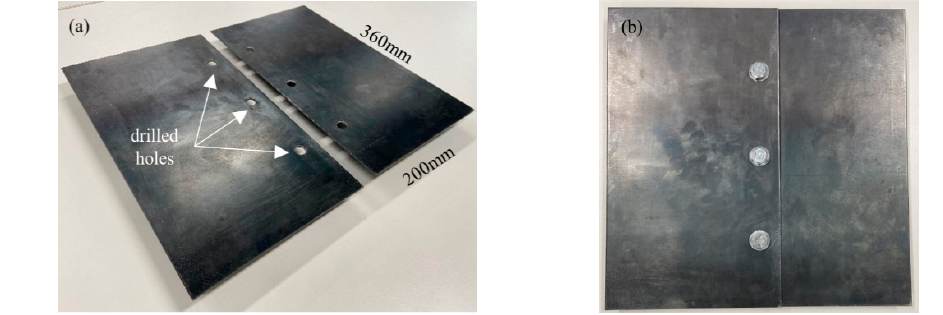
Figure 2. Steel specimens ( a ) before joint; ( b ) after bolted